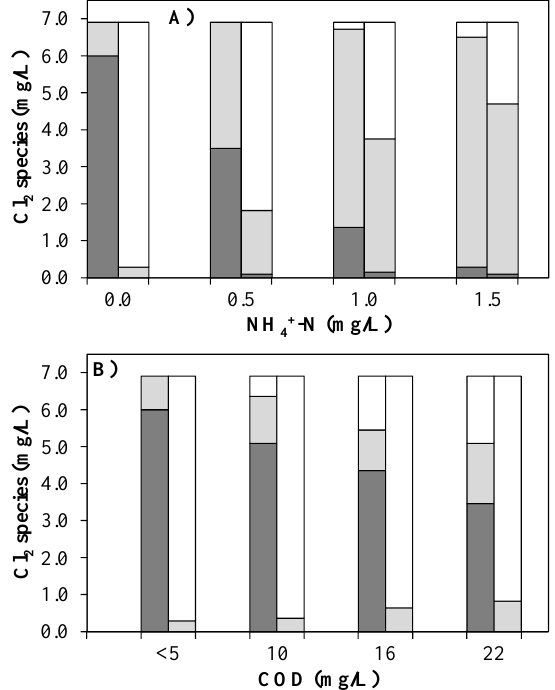
Figure 6. Combined Cl 2 in the UV chamber influent ( ) and pilot plant effluent after treatment of 1 m 3 /h NH 4+ -loaded WWTE with CC (no UV) ( ), UV/CC (0.4 kW, no quenching) ( ) and UV/CC (0.4 kW, 3.0 – 4.5 mg/L H 2 O 2 quenching) ( ) by means of an AOP pilot plant (Exp. C).